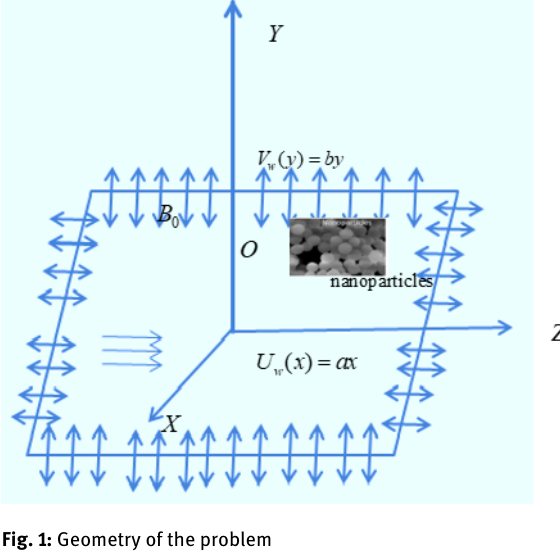
Fig. 1: Geometry of the